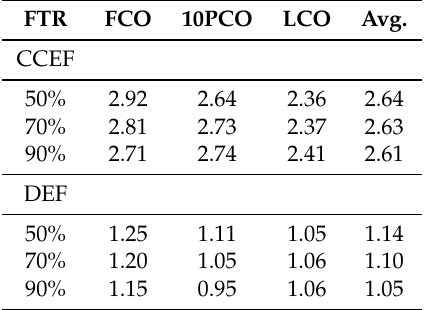
Table 2. Network lifetime gain of adaptive en-route filtering (AEF; times) over commutative cipher-based en-route filtering (CCEF) and dynamic en-route filtering (DEF).